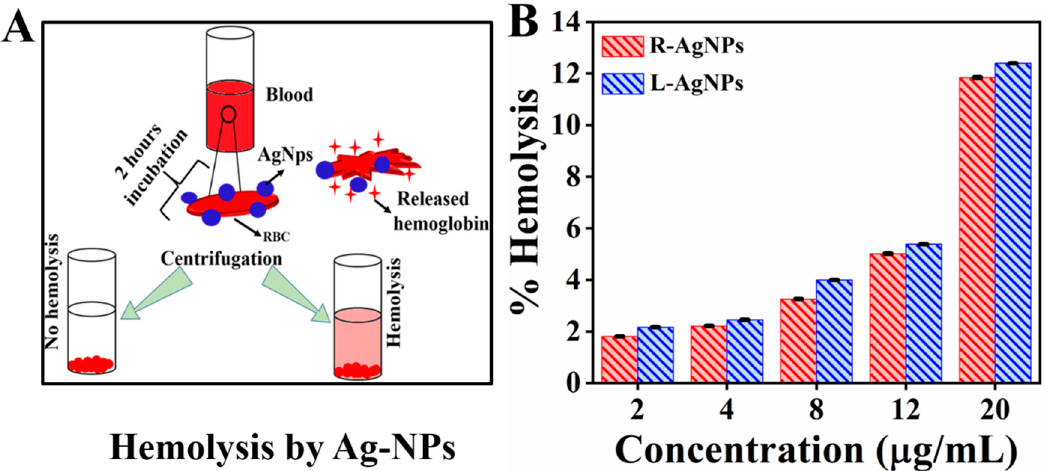
Figure 10. ( A ). Schematic presentation of hemolysis process ( B ). % hemolysis of synthesized nanoparticles at different concentration. The positive and negative control showed 100 (±0.001) and 0 (±0.001) % hemolysis.